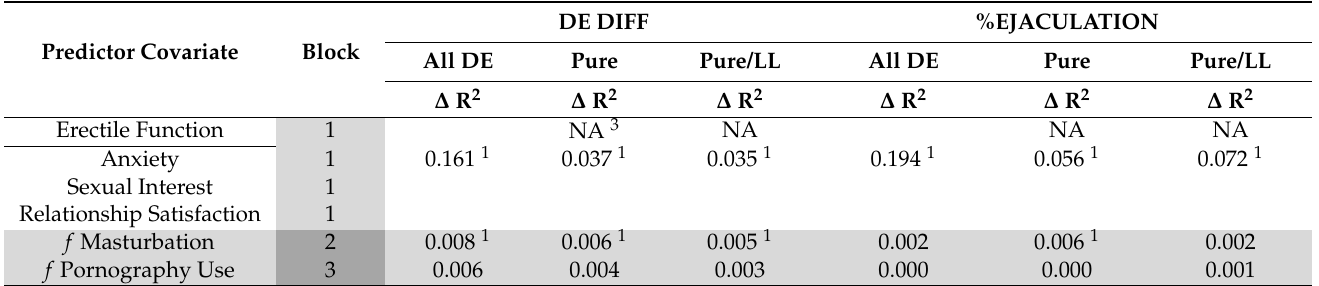
Table 4. Summary of block entry method (1, 2, 3), showing the additional explained variance of DE symptomology ( ∆ R2) due to inclusion of frequency of masturbation and pornography use (grey